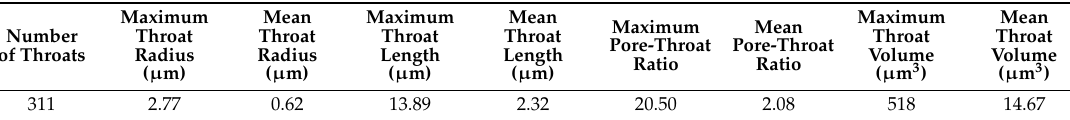
Table 2. Quantitative analysis results of the throat size.